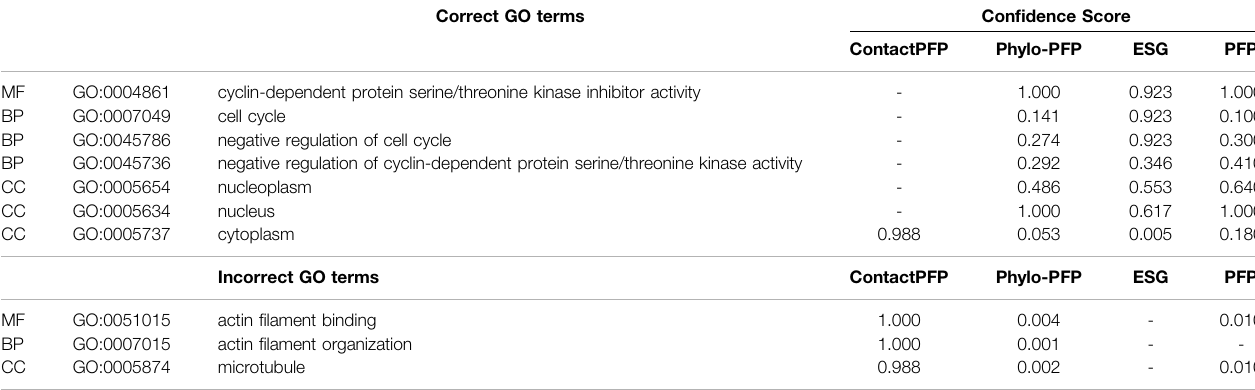
TABLE 5 | The detail of predicted GO terms for Cyclin-dependent kinase inhibitor 4 (UniProt ID: Q8GYJ3). Correct GO terms Con fi dence Score